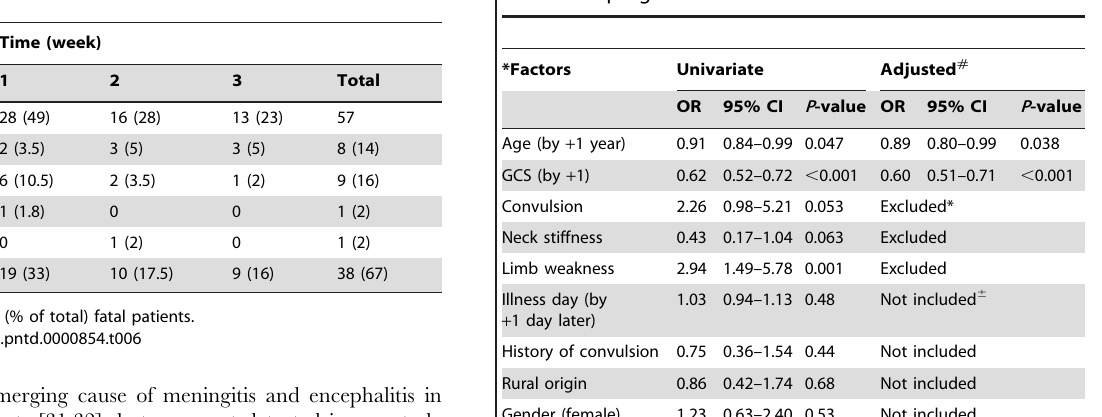
Table 6. Time (week) to death since onset of illness. Table 7. Univariate and adjusted logistic regression to determine prognostic factors of fatal